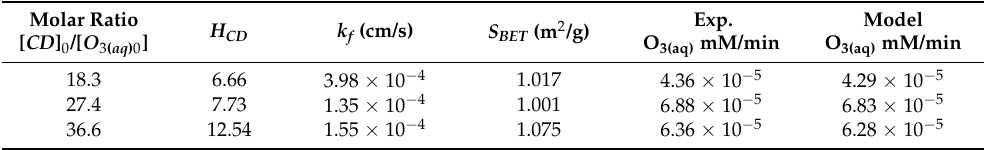
Table 2. Experimental and model-predicted O 3 release rate from the O 3 - β CD inclusion complex under different β -CD to O 3 molar ratios at pH